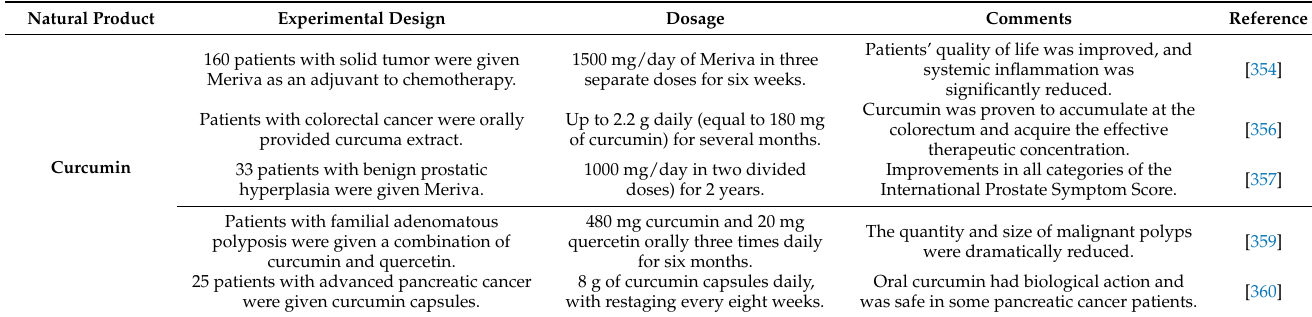
Table 2. The examples of clinical studies of natural